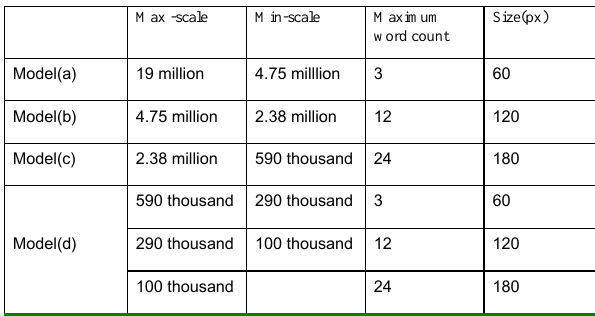
Table 1. Each model’s empircal parameters